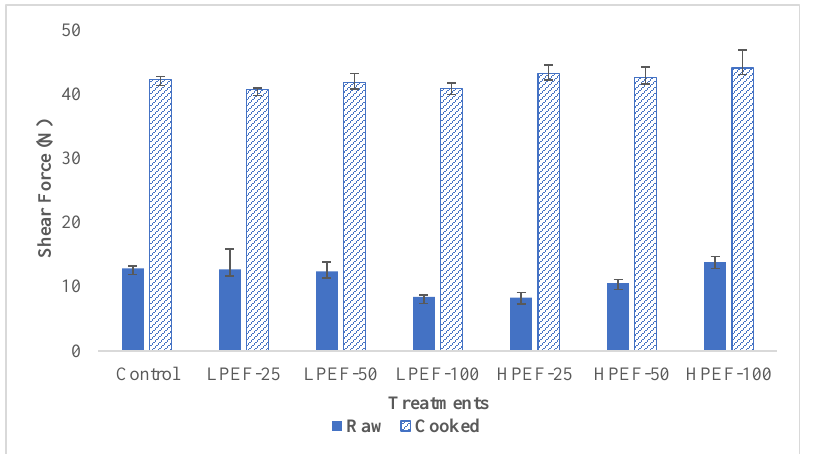
Figure 3. Effect of different pulsed electric field treatments on the shear force (N) of chicken meat samples compared to the untreated control (control). Foods 2023 , 12 , x FOR PEER REVIEW